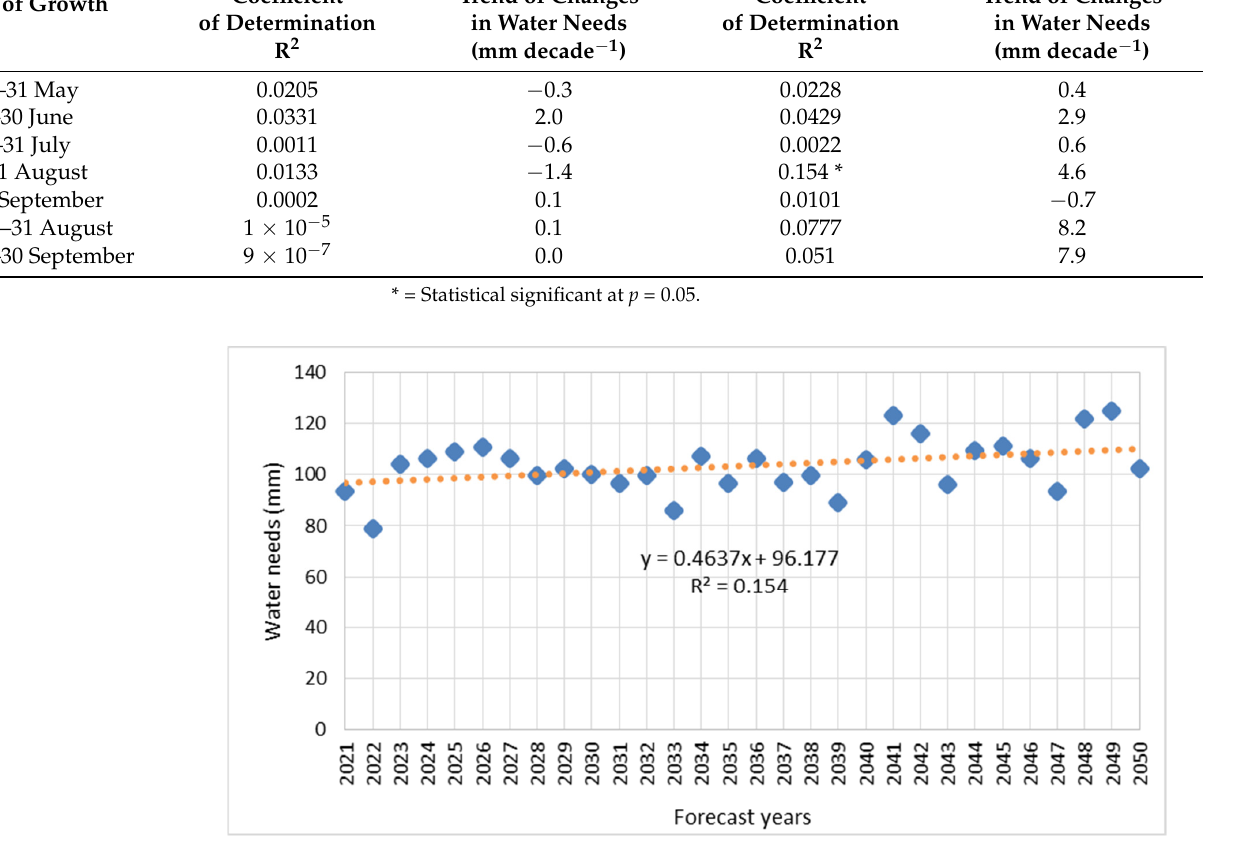
Spell of Growth